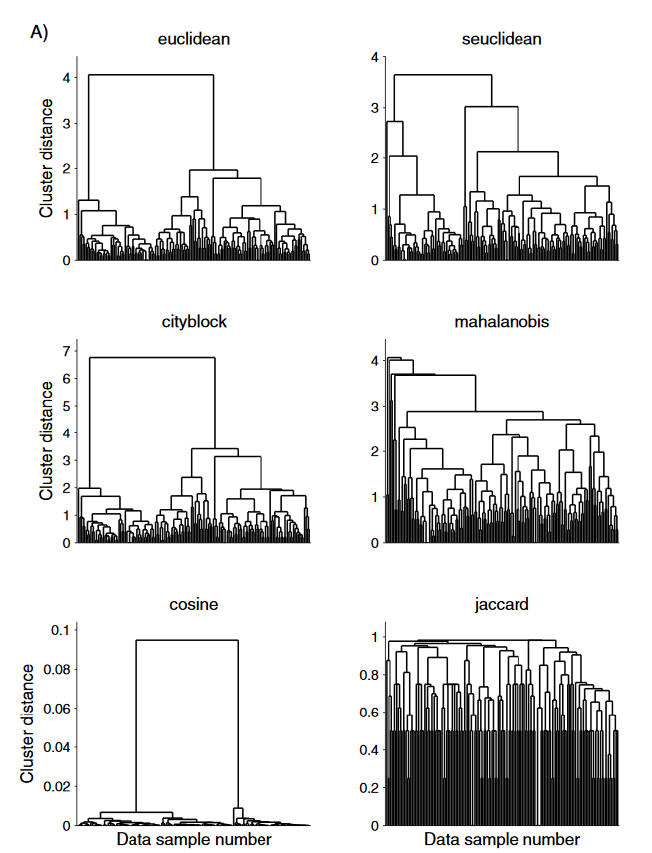
different distance metrics (Fisher, 1936).